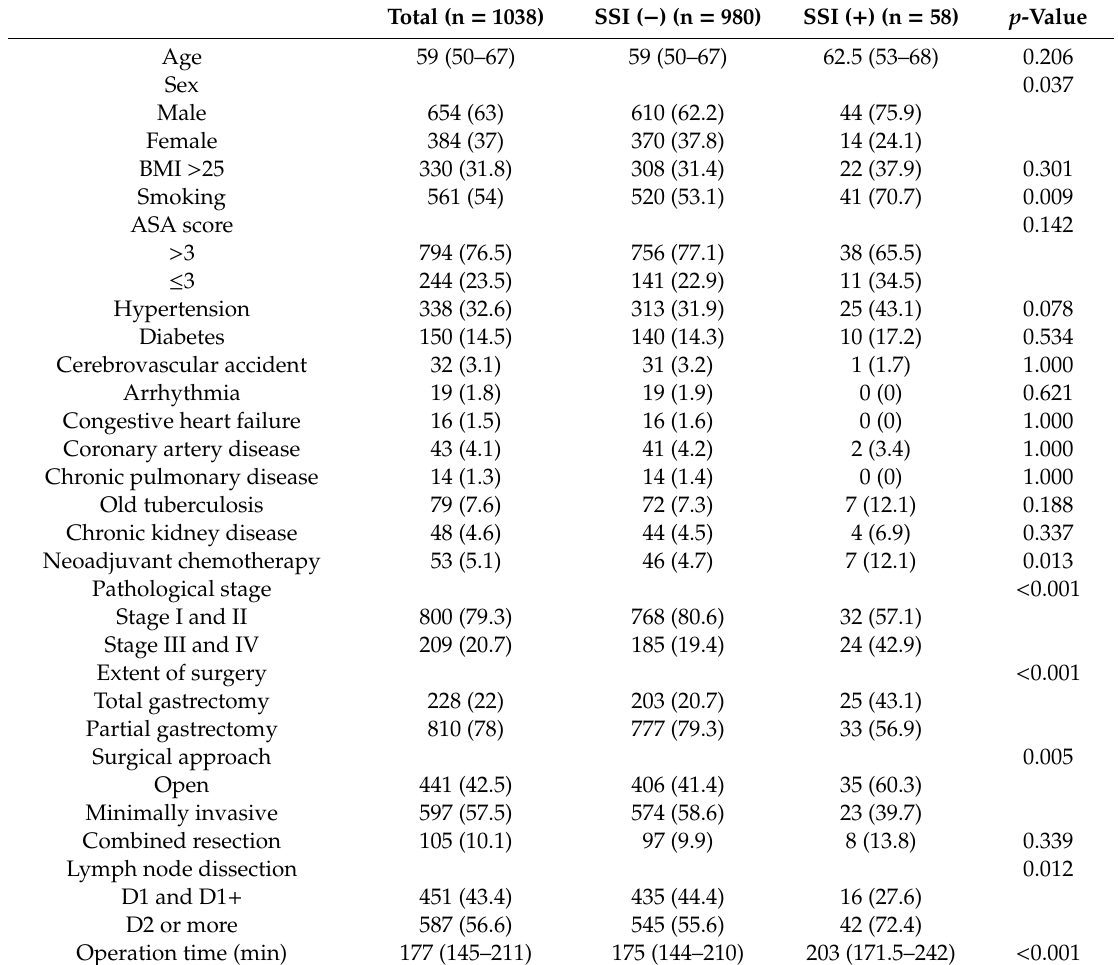
Table 1. Clinical characteristics of patients with surgical site infection after